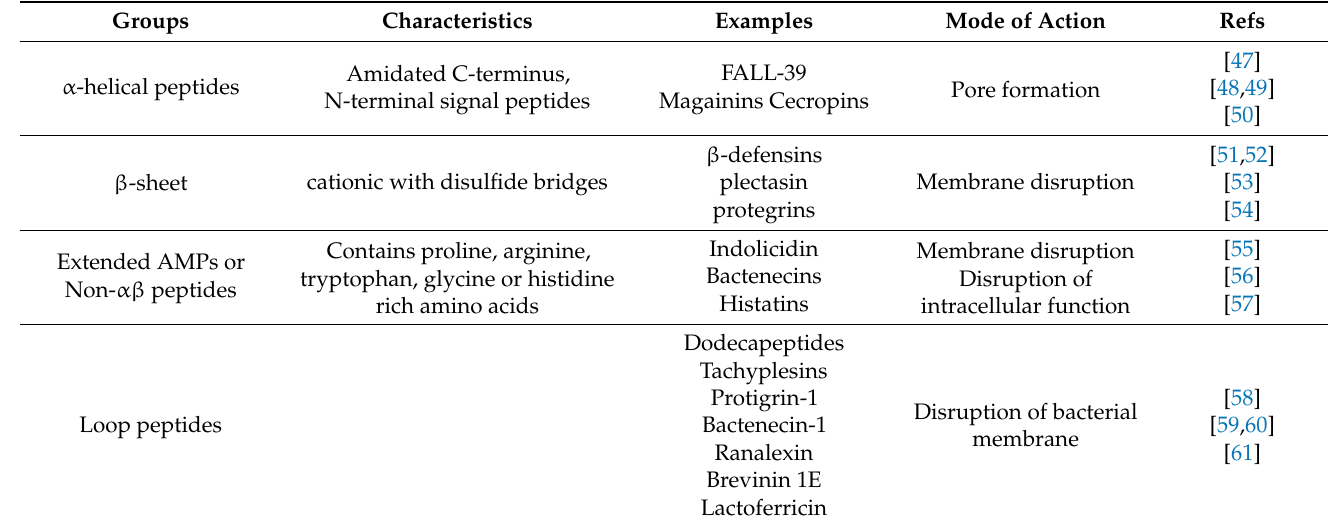
Table 1. Classifications of some AMPs with specific examples.